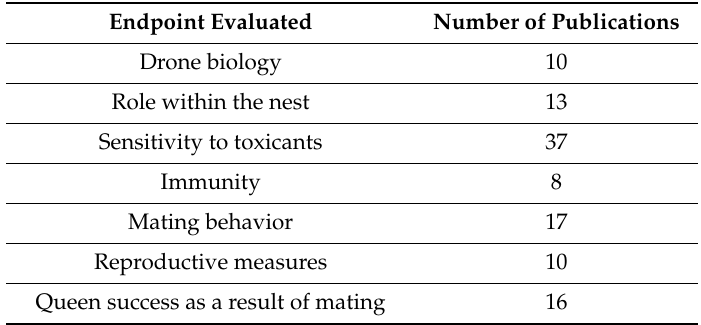
Table 1. Number of publications identified for each